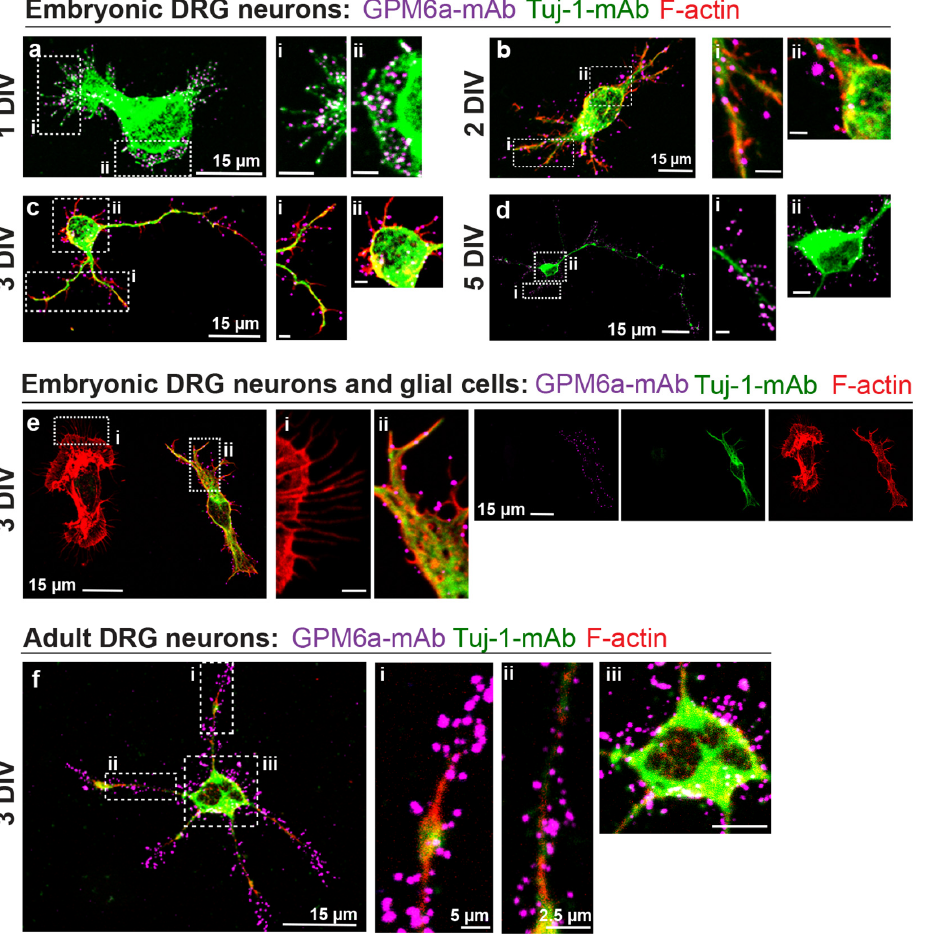
Figure 3. Endogenous GPM6a is expressed in a punctate pattern in the somas and processes of primary cultures of DRG neurons. Representative images of embryonic ( a – d ) and adult ( f ) dissociated cultured DRG neurons at different stages of development are shown. N = 3 independent experiments and n = 10–20 cells per condition (DIV, days in vitro) were analyzed. Each experiment had at least three wells per conditions (n = 3 technical replicates). Images show positive immunostaining for GPM6a in magenta (GPM6a ‐ mAb), β‐ tubulin III in green (Tuj ‐ 1 ‐ mAb), and actin in red (F ‐ actin). GPM6a expression was within the neuronal processes (insets i for embryonic and insets i/ii for adult neurons) and the soma (insets ii for embryonic and inset iii for adult neurons). Confocal images were acquired using a 60× objective and 4× ( a ), 2× ( b ), 3× ( c , f ), and 1.3× ( d ) digital zoom. Images are maximal projections of 4 z ‐ stacks ( a ), 3 z ‐ stacks ( b ), 3 z ‐ stacks ( c ), 6 z ‐ stacks ( d ), and 4 z ‐ stacks ( f ) and 0.15 μ m step size ( a – d , f ). Scale bars for the insets represent 5 μ m. ( e ) Representative confocal images of embryonic dissociated DRG neurons depicting contaminating glial cells at 3 DIV. Cells were immunostained with Tuj ‐ 1 ‐ mAb (green) and F ‐ actin (red) to differentiate neurons from other cells. Endogenous GPM6a was detected with GPM6a ‐ mAb antibodies (magenta). GPM6a expression was observed only within neurons (ii) and not glial cells (i). Insets: 20 × 10 μ m. Confocal images were acquired using a 60× objective and 2× digital zoom. Images are maximal projections of 4 z ‐ stacks and 0.15 μ m step size. All confocal images were acquired with an Olympus FV1000 confocal microscope.